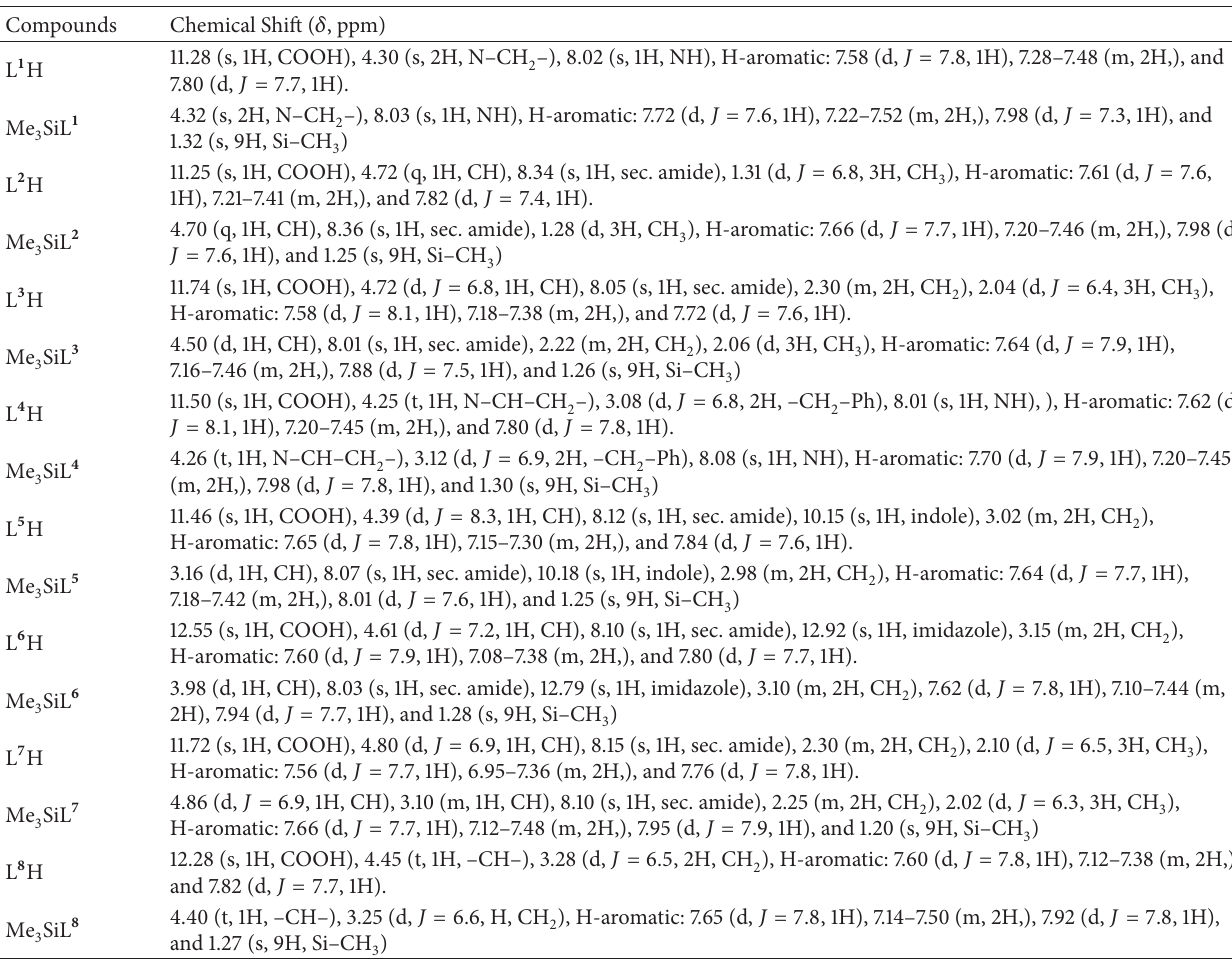
Si(IV) complexes. 3